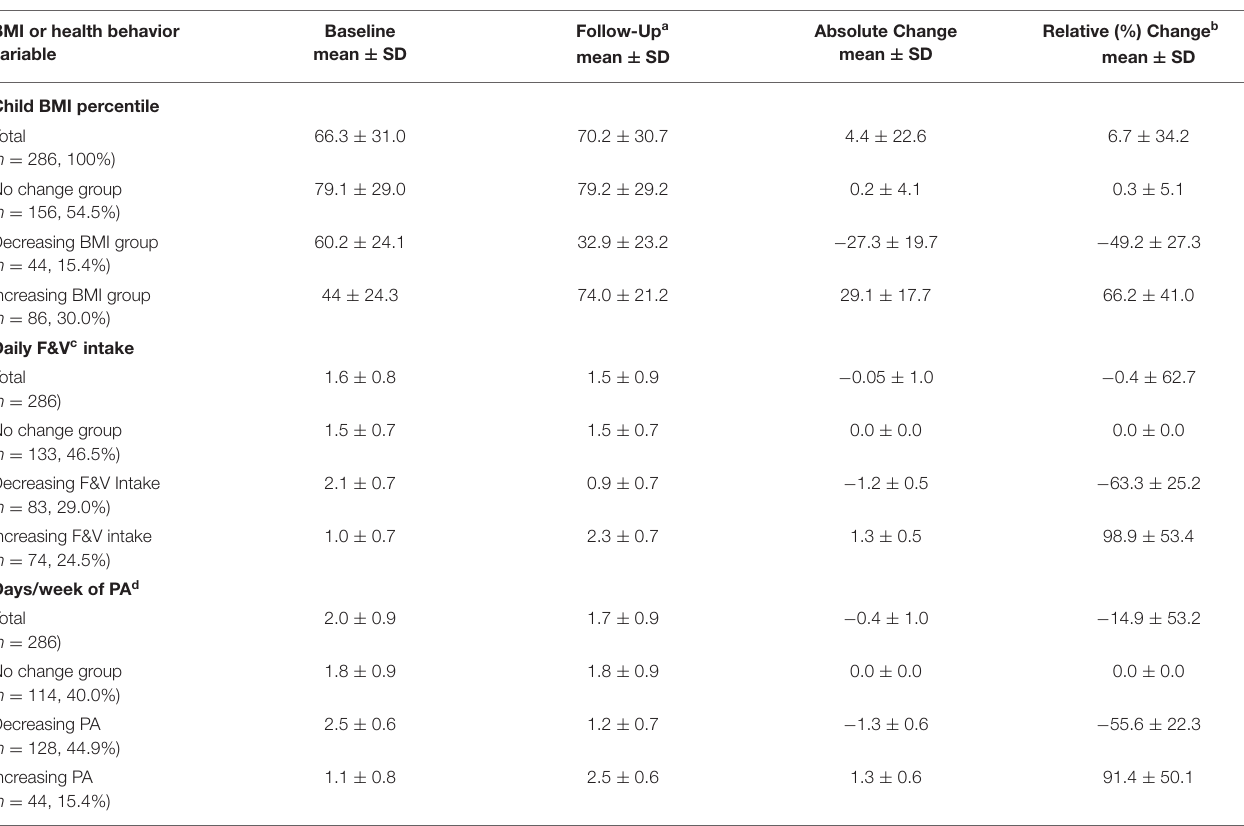
TABLE 2 | Baseline and follow-up status, and longitudinal changes in Body Mass Index (BMI) and health behaviors among children enrolled in the Go Austin! Vamos Austin! Cohort study